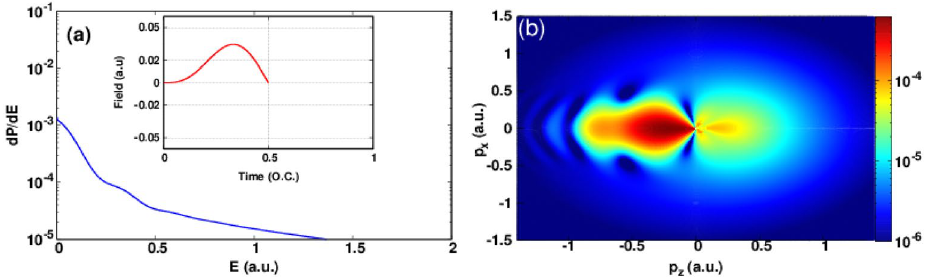
Figure 1. ( a ) Photoelectron spectra for a half-cycle electric field of frequency ω = 1.55 eV ( (cid:31) = 800 nm) corresponding to the intensity 1 × 10 14 W / cm 2 ( E 0 = 0.0534 a.u.). The carrier envelope phase is fixed at 0. Inset: electric field as a function of time in optical cycle unit. ( b ) Photoelectron momentum distribution in the plane ( p x , p z ) in logarithmic scale for the same laser pulse characteristics associated with ( a ), this heat map was generated using Gnuplot software (www. gnupl ot. info), version [5.4] for Unix system.